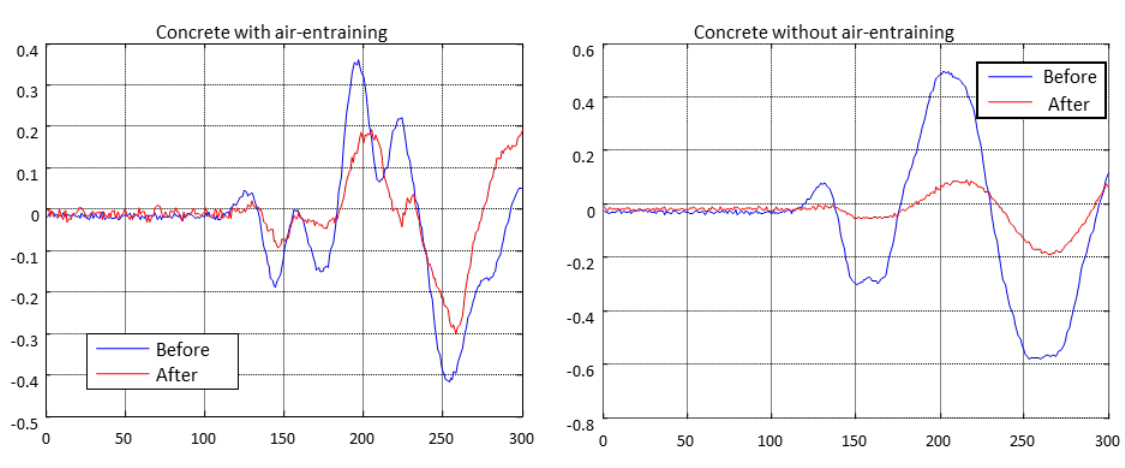
Figure 14. A-scan of concrete specimens, with and without air entrainment, before and after the cycles.